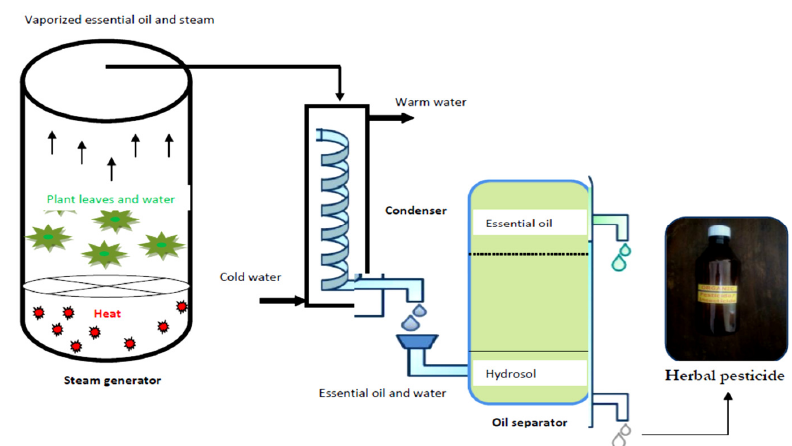
Figure 1. Pictorial representation of essential oil distillation and obtained by-product Total phenolic